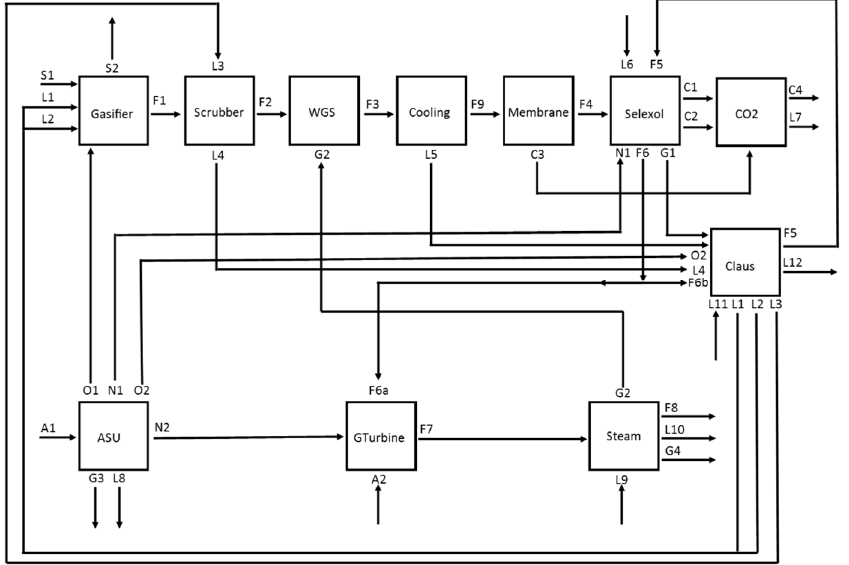
Figure 3. Carbon Dioxide Membrane Model process flow diagram.